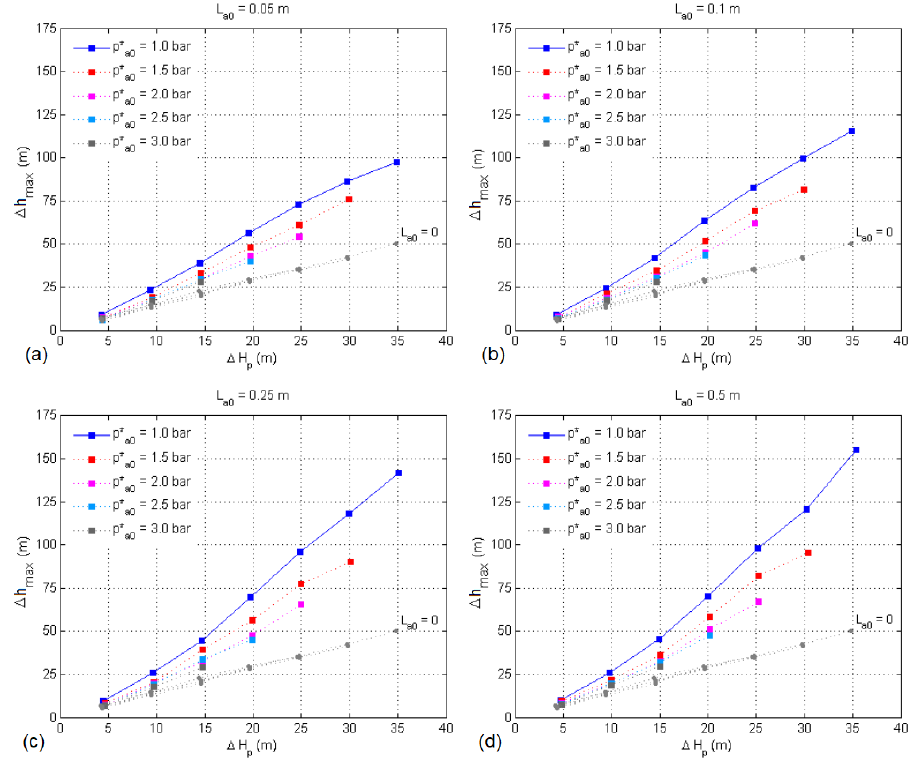
Figure 3. Maximum piezometric head differential versus initial load differential for different air pocket sizes and initial air pocket pressures for system subject to pipeline filling: ( a ) L a 0 = 0.05 m;